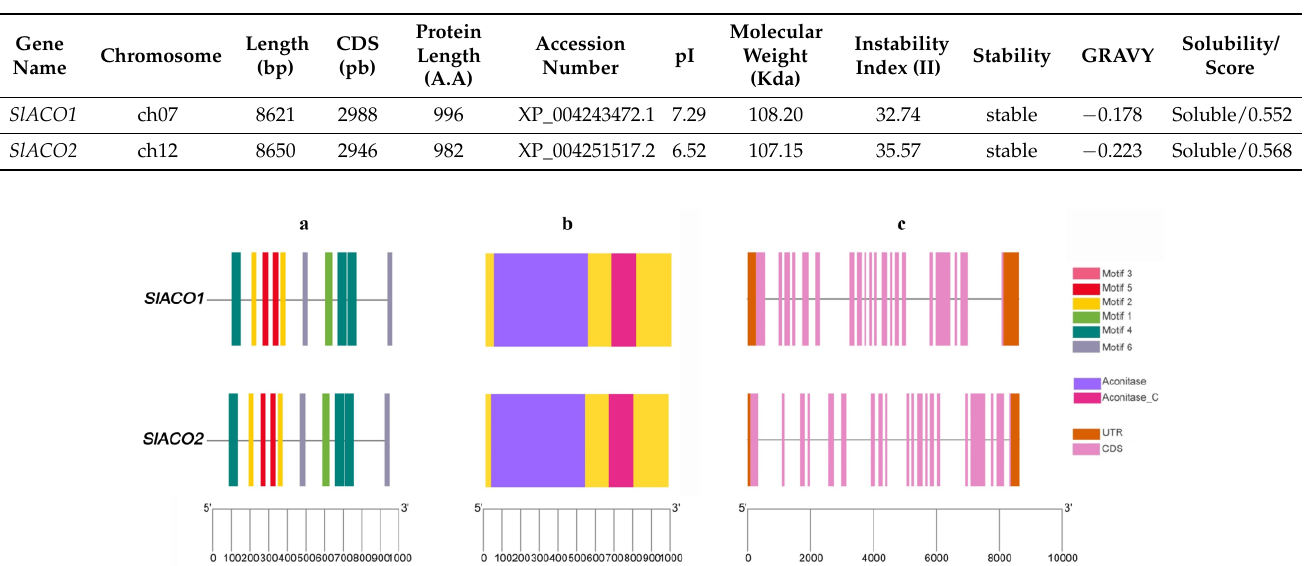
Table 1. Physiochemical properties of SlACO proteins.